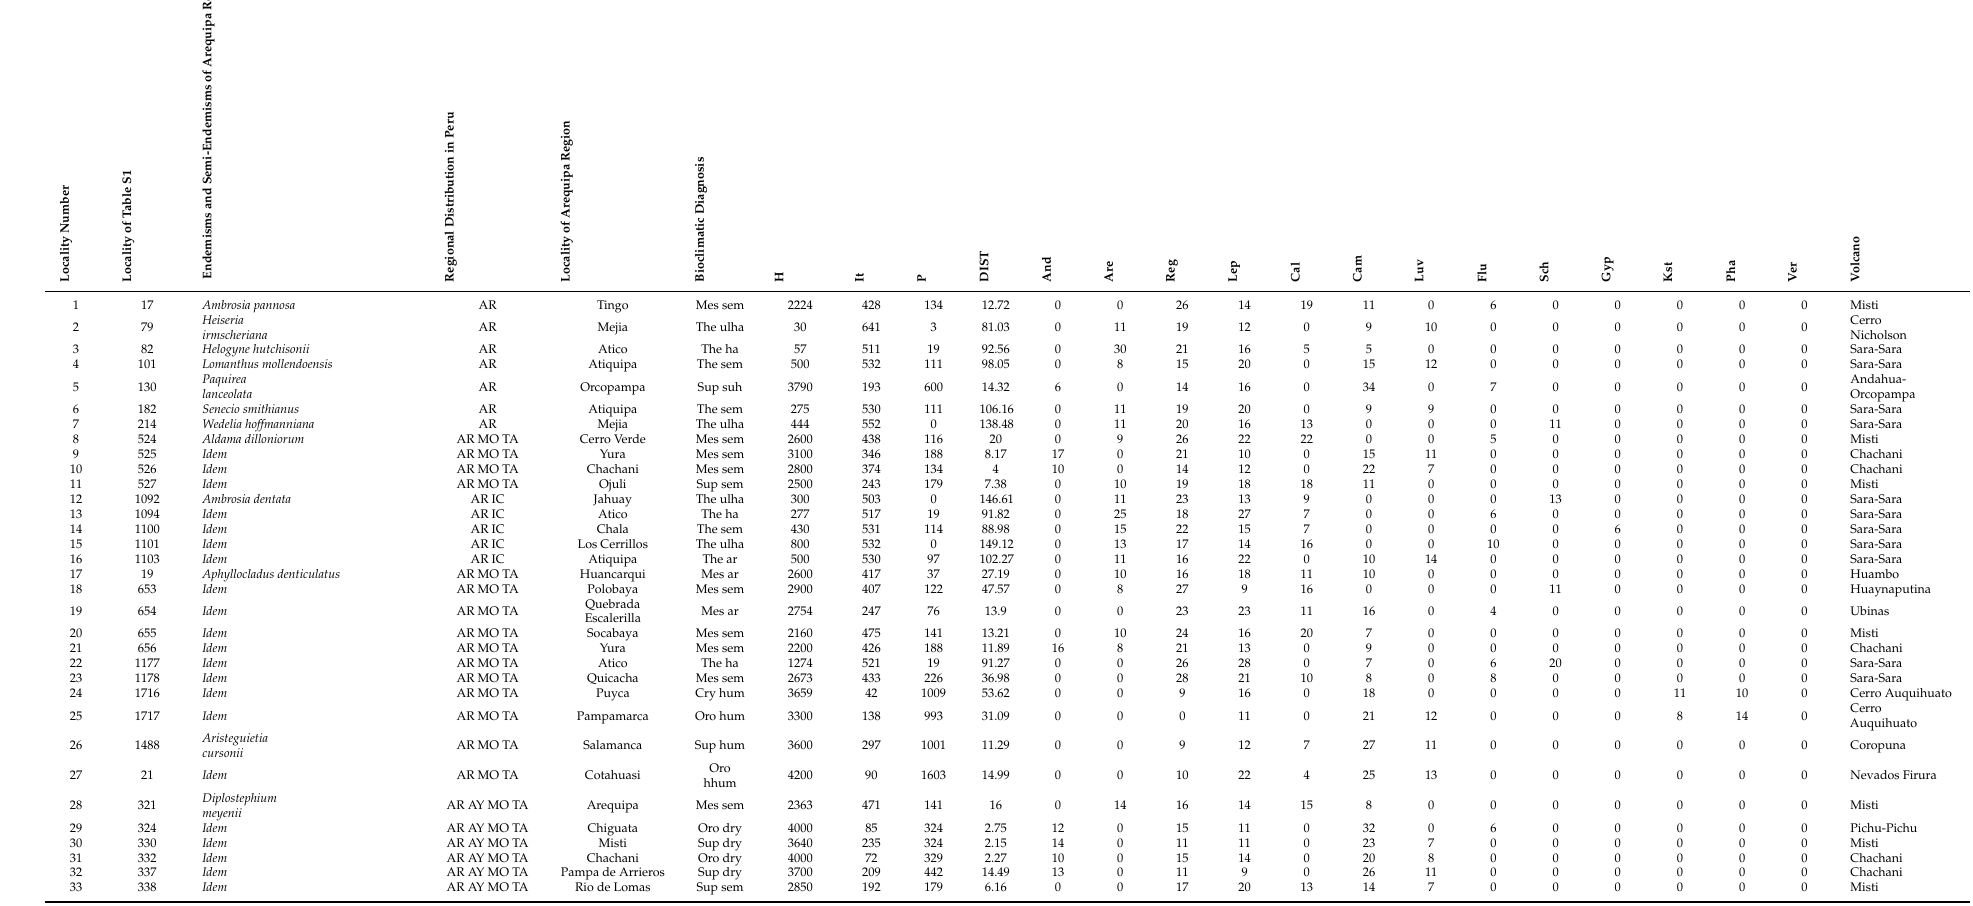
Table A1. Table with the values taken to obtain the PCA of Figure 2, bioclimatic diagnosis, volcanoes closest to the localities studied, and percentage of soil types per pixel of SoilGrids database in a locality (Synthesis of the Supplementary Table